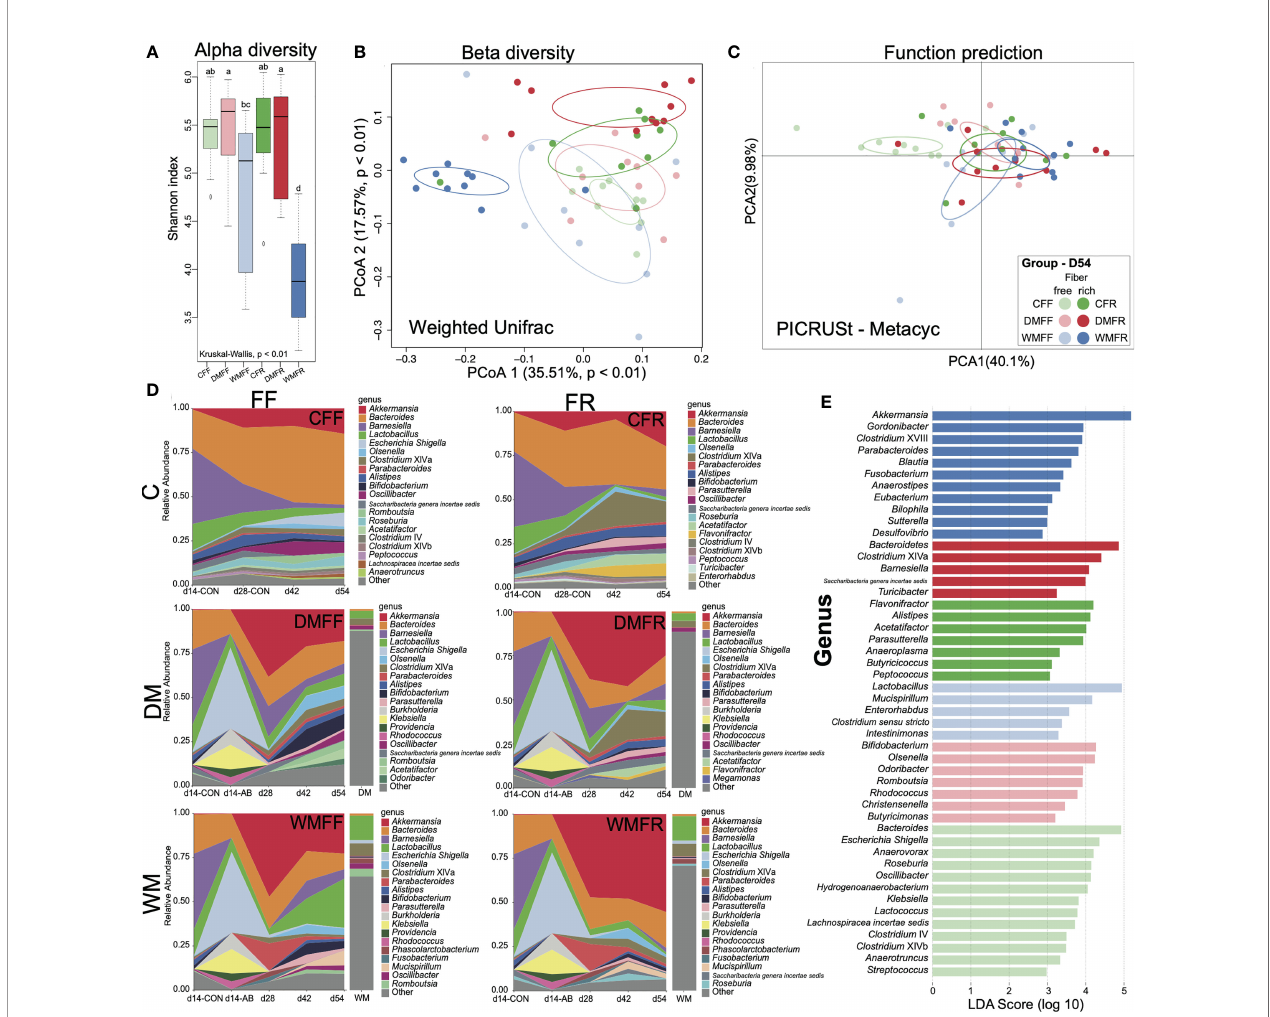
FIGURE 4 | Bacteria communities in mice treated with fecal microbiota transplantation (FMT) together with dietary fi ber intervention at day 54. (A) Boxplot of Shannon index of gut microbiota in mice. (B) Principal coordinates analysis (PCoA) of gut microbiota structures in the mice between six groups. (C) Principal component analysis (PCA) of the functional content of gut microbiota predicted by PICRUSt in the mice among six groups. (D) Changes in the relative abundance of gut microbiota over time in mice oscillated among FMT and fi ber feeding. (E) Bar charts showed the linear discriminant analysis (LDA) score (>2) for the gut microbiota in the mice. Kruskal – Wallis test with an adjusted p- value of <0.01 was used. a,b,c,d Means within the same row followed by different superscripts differ at p <